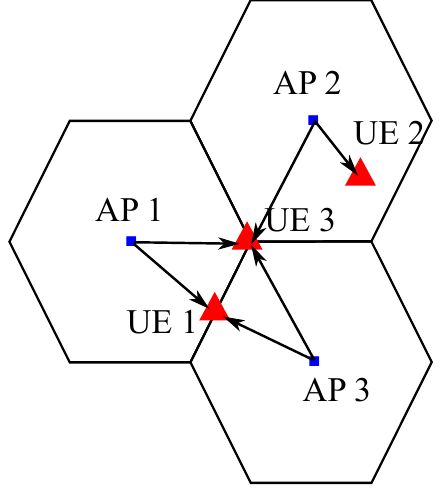
Figure 14. Toy example of